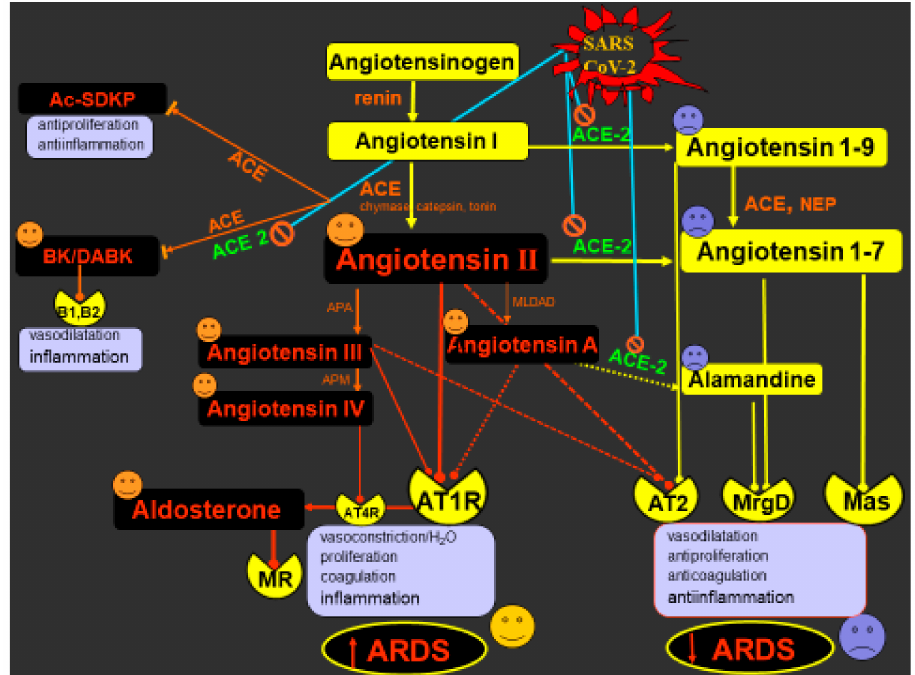
Figure 1. Severe acute respiratory syndrome coronavirus (SARS-CoV-2) interactions with the renin– angiotensin–aldosterone system (RAAS). SARS-CoV-2 binds with membrane ACE2, reducing its membrane expression (by internalization or shedding) and resulting in attenuated formation of angiotensin 1-9, angiotensin 1-7 or alamandine; this results in reduced stimulation of AT2R, Mas and Mrg receptors and their protective cardiovascular and anti-inflammatory actions. On the other hand, downregulated Ang II conversion to Ang 1-7 enhances the bioavailability of Ang II, Ang A and aldosterone, with subsequent stimulation of AT1R and MR resulting in pro-proliferative and pro-inflammatory actions. Both the reduced ACE2/Ang 1-7/Mas/AT2/MrgD protective path- way and the stimulated ACE/Ang II/AT1 deleterious route accelerate inflammation and ARDS development. Furthermore, Ang II is degraded to its active splitting products Ang III and Ang IV by the aminopeptidases A and M. While Ang III can support the action of Ang II via AT1R, Ang IV increases pro-inflammatory genes via interaction with the AT4 receptor. In addition, down- regulation of ACE2 may enhance the bioavailability of bradykinin and its proinflammatory effect and the potentially protective N-acetyl-seryl-aspartyl-lysil-proline (Ac-SDKP) is